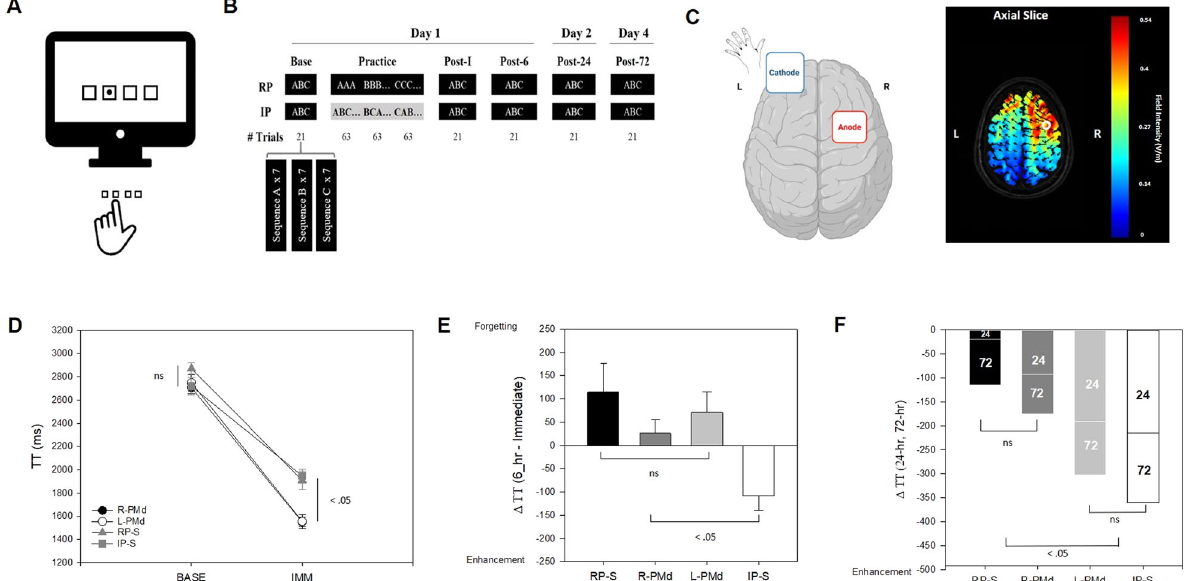
Fig. 1 The experimental procedure with tDCS montage used to examine motor memory enhancement. Participants in the present study practiced three unique six-element motor sequences that were executed using the left index fi nger only with each key-press in the sequence made in response to a visual signal presented on the display ( A ). In the present work, repetitive practice (RP) involved the practice of a single sequence for a total of 63 trials prior to practice with another sequence. There were three sequences practiced in the RP condition. Interleaved practice (IP) involved 21 trials for each of the three to-be-learned motor sequences in each block of 63 trials. All test blocks (Base, Post-I, Post-6, Post-24, Post-72) involved seven trial for each sequence practice in a RP format ( B ). Anodal tDCS at right or left PMd was administered for individuals experiencing RP and consisted of the anode being located 2.5 cm anterior of M1 with a reference electrode at the supraorbital region ( fi gure illustrates right PMd montage only). The human brain icon was adapted by Biorender.com. The current fl ow associated with this electrode montage was modeled using tDCS-Explore TM (Soterix Medical Inc., New York, NY) ( fi gure illustrates right PMd only). Heightened current fl ow was observed (.229 V/m, .406 V/m) at MNI coordinates (x: − 29, y: − 1, z; 44 and x: 29, y: − 1, z; 44). These locations (noted with white circle) fell within the boundaries described as left-PMd and right-PMd respectively in the human motor area template 12 ( C ). Online gain, re fl ected in the change in TT from the test administered prior to practice and one given immediately after the conclusion of training, did not differ as a function of the location of anodal tDCS at PMd but was signi fi cantly greater than that observed for individuals in RP-S and IP-S ( D ). The change in TT during the initial 6-hrs following RP supplemented with stimulation at PMd did not differ from that observed for the individuals that experienced RP-S but differed from the performance of individuals exposed to IP-S who revealed enhanced skill memory across the 6-hr interval after practice ( E ). While anodal tDCS at R-PMd failed to induce sleep-related performance improvement beyond that observed for RP-S, stimulation at L-PMd resulted in overnight skill memory enhancement congruent with that observed for the IP-S condition. This occurs following the initial night of sleep as well as for the subsequent assessment made following two additional nights of sleep (F) . RP-S Repetitive practice paired with sham stimulation, IP-S Interleaved practice paired with sham stimulation, L-PMd Repetitive practice paired with anodal tDCS at left PMd, R-PMd Repetitive practice paired with anodal tDCS at right PMd. tDCS transcranial direct current stimulation. All error bars are standard